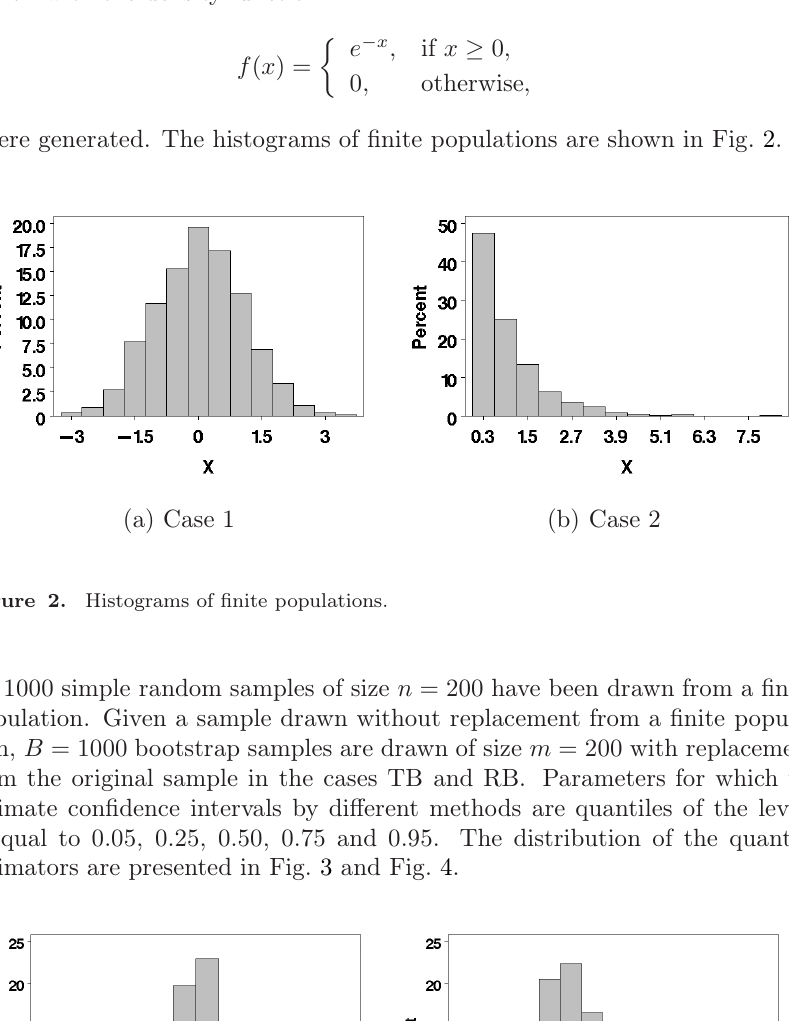
Figure 3. Distribution of the quantile estimator for the level 0 . 05 . Histograms of 1000 quantile estimates in each